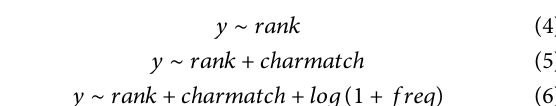
Table 9 . Pr ( correct ) ≈ σ ( z ) where σ ( z ) (cid:2) 1/(1 + e − z ).